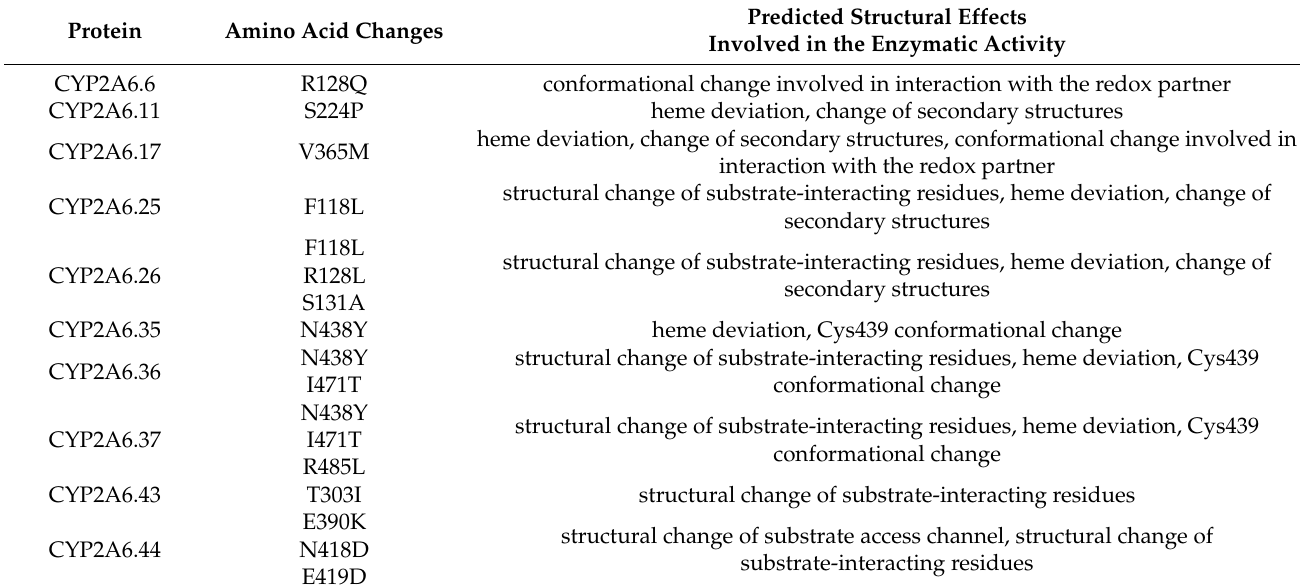
Table 10. Structural effects observed in the calculated structures of CYP2A6 mutants. Protein Amino Acid Changes